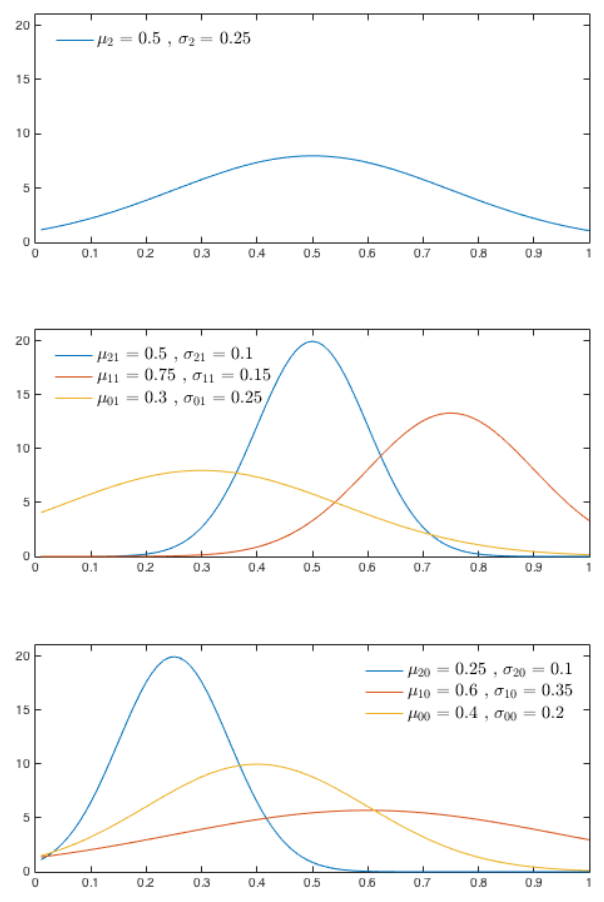
Figure 3. Functions g w and the corresponding values of µ w and σ w for w ∈ τ = { 2,11,21,01,00,10,20 } : ( top ) function g 2 ; ( middle ) functions g 21 , g 11 and g 01 ; and ( bottom ) functions g 20 , g 10 and g 00